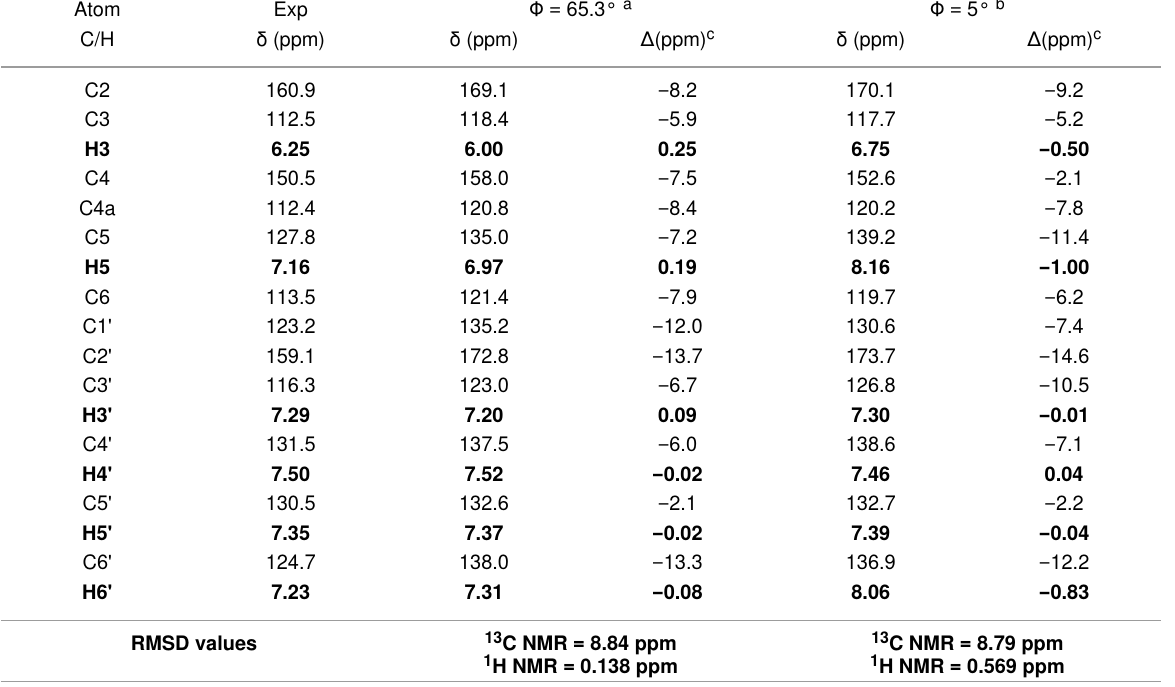
Table 1: Experimental and theoretical (gas phase) 1 H and 13 C chemical shift ( δ ) for atoms within six bonds from fluorine for coumarin 6 and RSMD